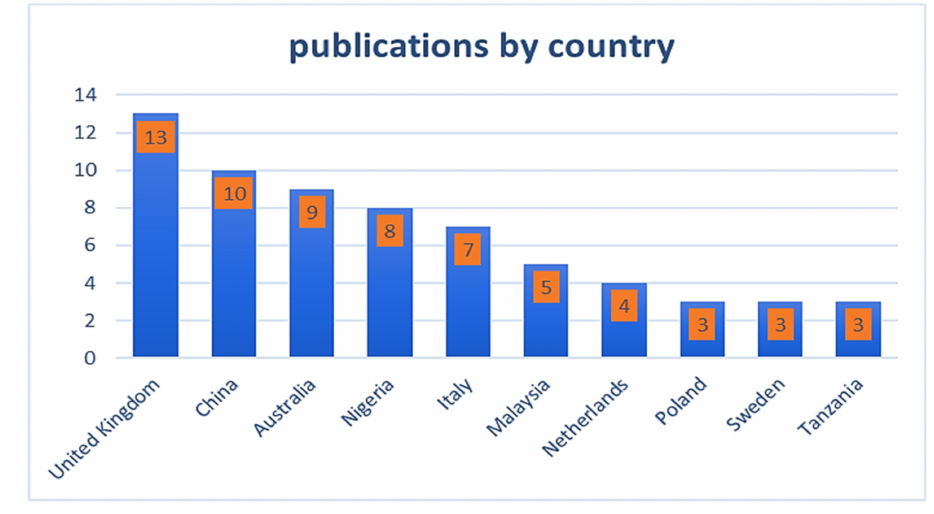
Figure 6. Number of publications by country/region.